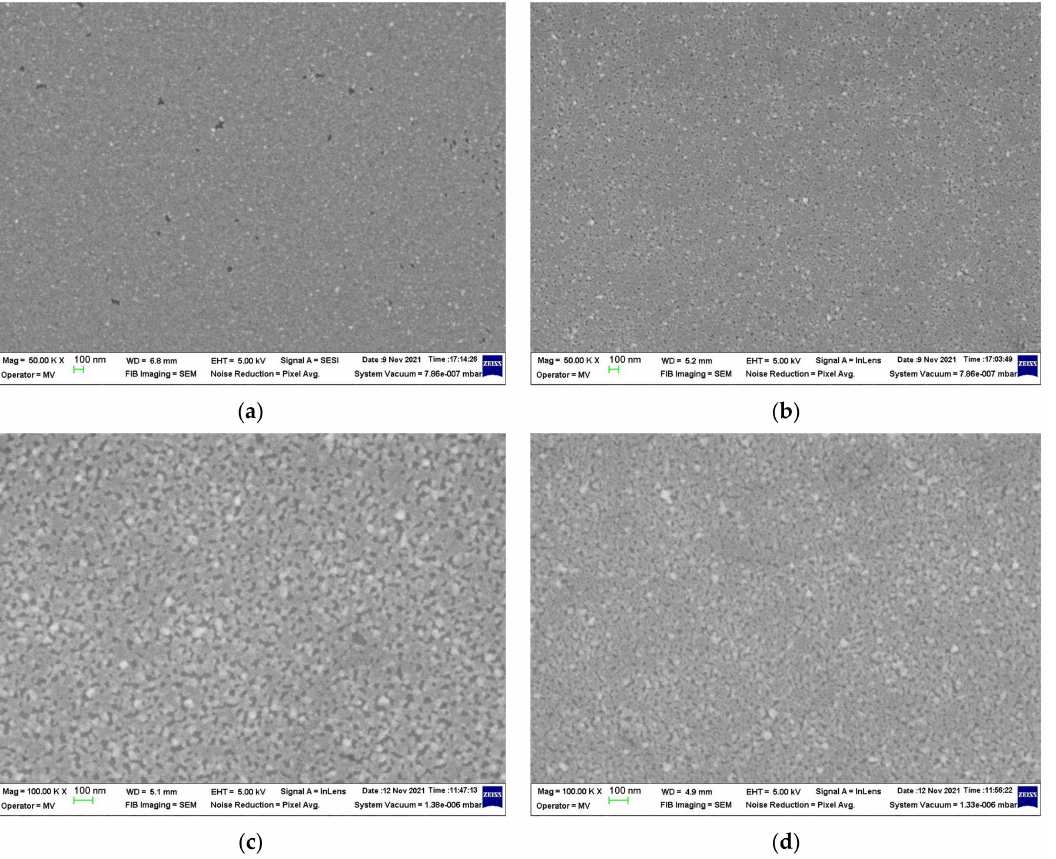
Figure 5. SEM images of the Ag samples obtained at different DC power inputs: ( a ) AgDC250, ( b ) AgDC200, ( c ) AgDC150, and ( d ) AgDC100.